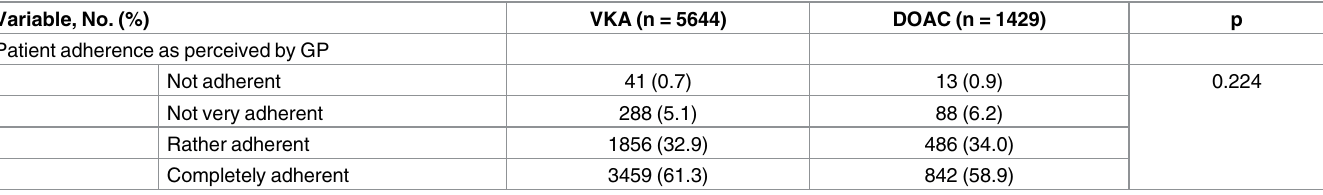
Table 4. General practitoner’s perception of patient’s adherence to anticoagulation. Variable, No.